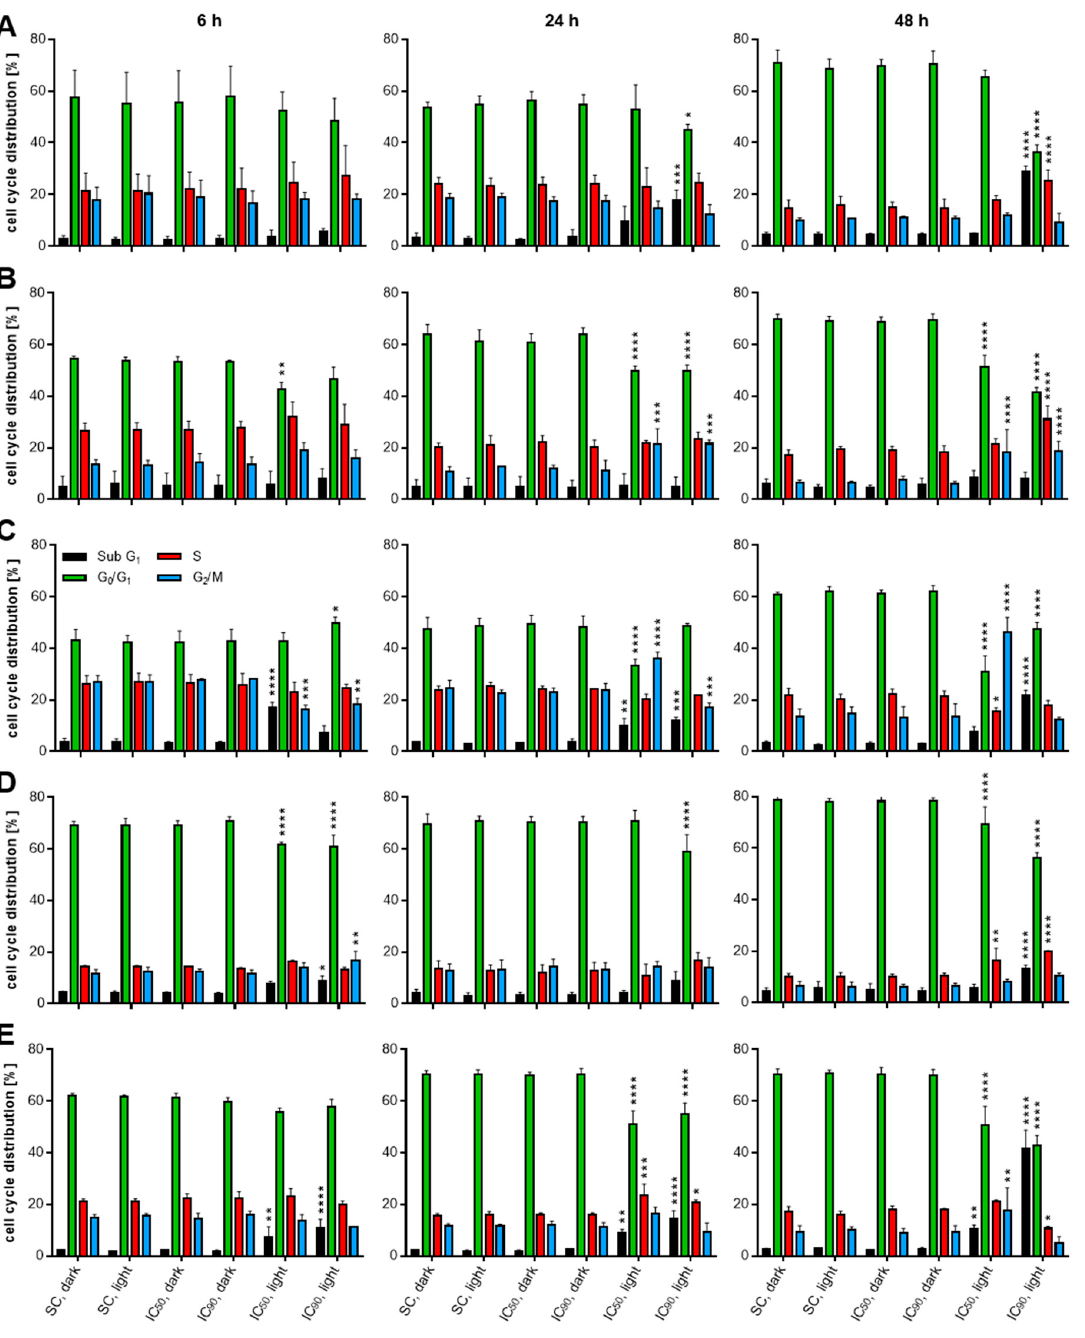
Figure 9. Cell cycle analyses of A-427 ( A ), BHY ( B ), KYSE-70 ( C ), RT-4 ( D ), and SISO ( E ) cells after mTHPC-PDT. Cells were treated with either solvent (SC) or equitoxic concentrations (IC 50 or IC 90 in Table 1 of mTHPC between 0.02–0.3 µM, illuminated with 1.8 J/cm 2 or left in the dark, stained with PI and analyzed 6 (left), 24 (middle), or 48 h (right) after photodynamic treatment. Flow